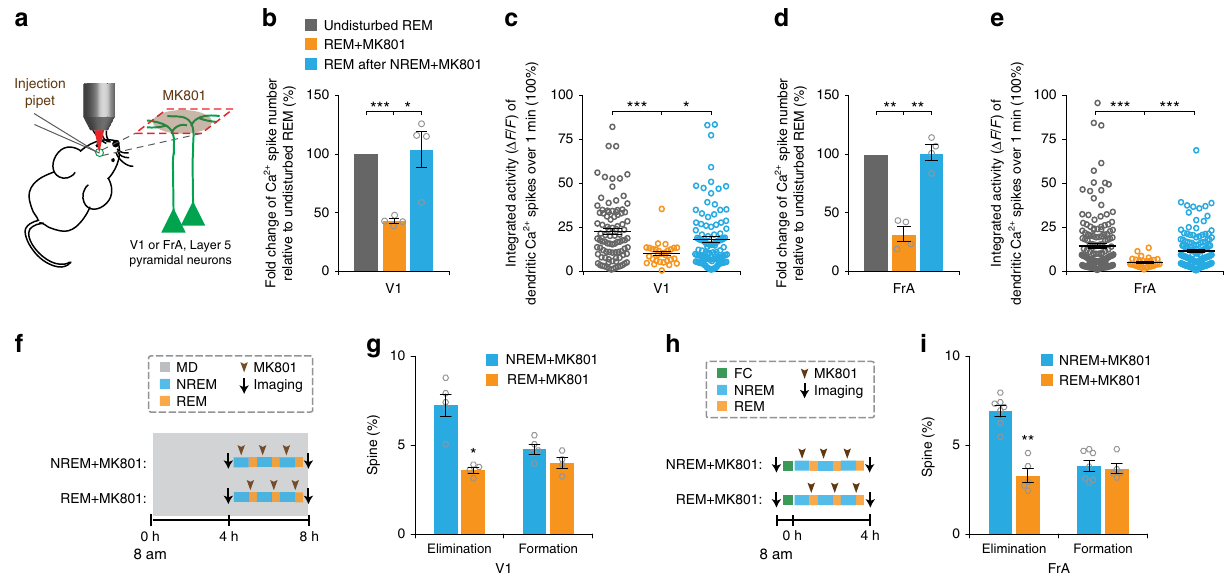
Fig. 6 Blockade of dendritic Ca 2 + spikes reduces spine elimination. a Schematic of local injection of MK801 into the layer 1 of the mouse cortex under a two-photon microscope. b , d Local and brief injection of MK801 at the beginning of each REM sleep episode, but not during NREM sleep, signi fi cantly reduced the number of dendritic Ca 2 + spikes during REM sleep as compared to that in undisturbed REM sleep in both V1 b ( n = 4 mice, P < 0.0001 and = 0.0362 for REM + MK801 vs. undisturbed REM sleep and REM after NREM + MK801, respectively) and FrA ( d ) ( n = 4 mice, P = 0.0017 and = 0.00097 for REM + MK801 vs. undisturbed REM sleep and REM after NREM + MK801, respectively) (paired t test, two-sided). c , e MK801 injection at the beginning of a REM sleep episode, but not during NREM sleep, signi fi cantly blocked the integrated activity of dendritic Ca 2 + spikes during REM sleep as compared to that in undisturbed REM sleep in both V1 ( c ) ( P = 0.0001 and = 0.0199 for REM + MK801 vs. undisturbed REM sleep and REM after NREM + MK801, respectively) and FrA ( e ) ( P = 0.0003 and < 0.0001 for REM + MK801 vs. undisturbed REM sleep and REM after NREM + MK801, respectively) (Wilcoxon – Mann – Whitney test, two-sided). f Schematic of experimental design to examine the effect of blocking dendritic Ca 2 + spikes on spine elimination induced by MD in V1. g MD-induced dendritic spine elimination was signi fi cantly reduced after brief MK801 injection in REM sleep over a 4-h period as compared to that in NREM-d mice ( n = 4 mice for REM + MK801; n = 5 mice for NREM + MK801, P = 0.0159, Wilcoxon – Mann – Whitney test, two-sided). h Schematic of experimental design to examine the effect of blocking dendritic Ca 2 + spikes on spine elimination induced after FC in